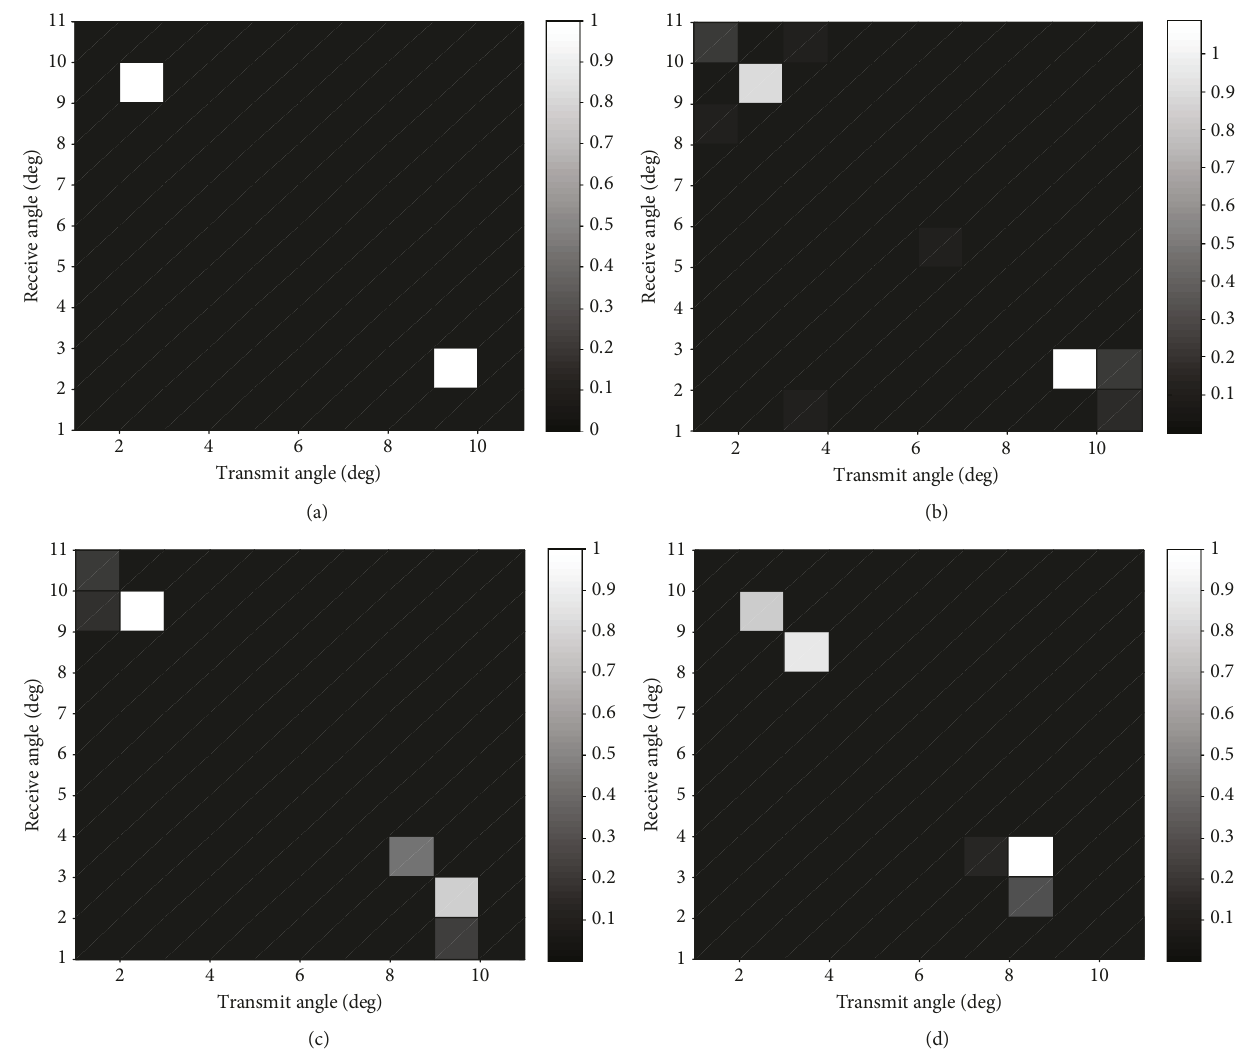
θ θ θ t 1 , r 1 = 2 ° , 9 ° , t 2 , r 2